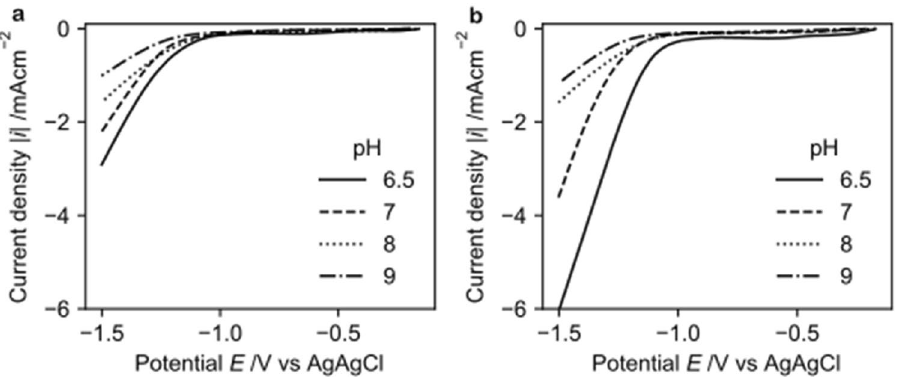
Figure 3. LSV taken using a copper electrode in 0.1 M Tris buffer flushed with N 2 at pH 6.5, pH 7, pH 8 and pH 9 with a scan rate of 0.1 V/s. ( a ) without NAD + ( b ) with 1.5 mM NAD +